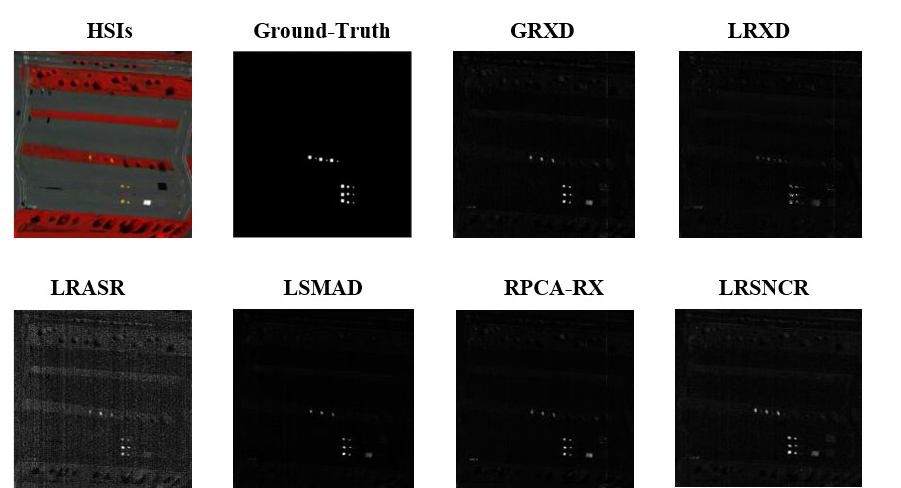
Figure 18. Detection maps by SpecTIR dataset.